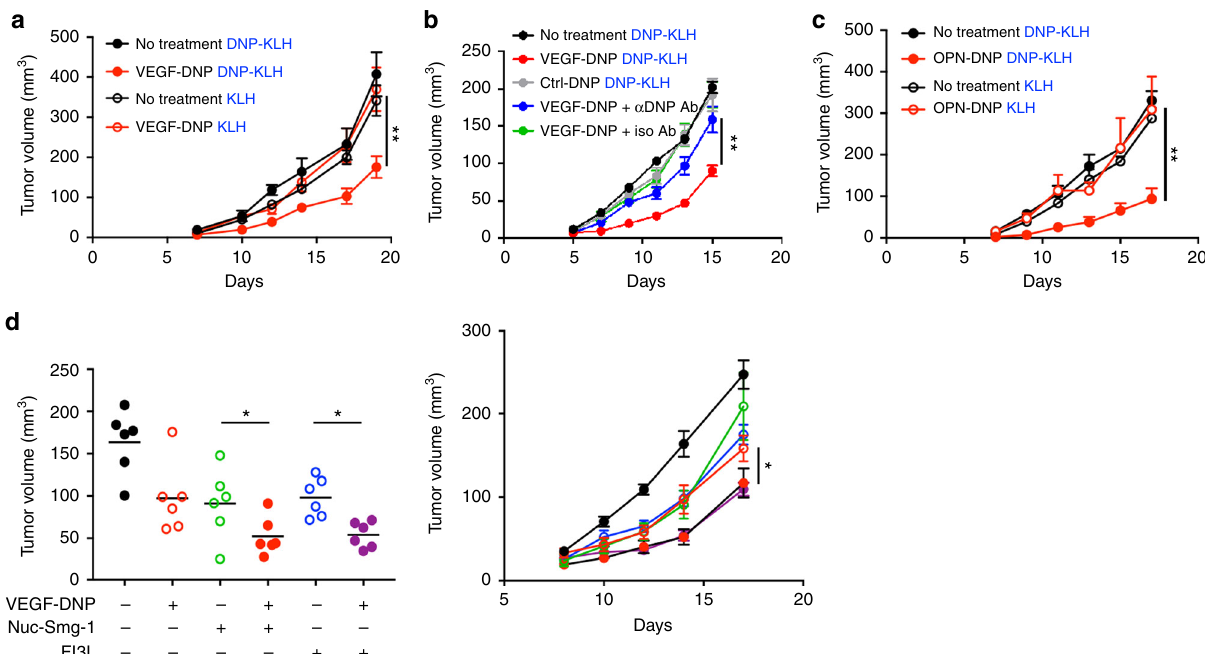
Fig. 2 Inhibition of tumor growth in DNP immune mice by targeting DNP to palpable subcutaneous 4T1 tumors. a Balb/c mice vaccinated against DNP (DNP-KLH) or mock vaccinated (KLH) were injected subcutaneously with 4T1 tumor cells. 7 – 8 days later when tumors became palpable 500 pmoles of VEGF – DNP was administered via i. p. injection three times 3 days apart and tumor growth was monitored. Statistical analysis, VEGF – DNP in DNP-KLH versus KLH, ** p = 0.0081, Student ’ s t -test. (7 mice per group) ( n = 2). b DNP-vaccinated mice were also treated with control aptamer conjugated to DNP (Ctrl-DNP) or non-vaccinated mice were injected with a mixture of VEGF – DNP and monoclonal anti-DNP or isotype antibody at a ratio of 1:2. (6 mice per group) Statistical analysis, VEGF – DNP in DNP-KLH versus VEGF – DNP + α DNP Ab ** p = 0.0066, Student ’ s t -test ( n = 1). c As in a except for